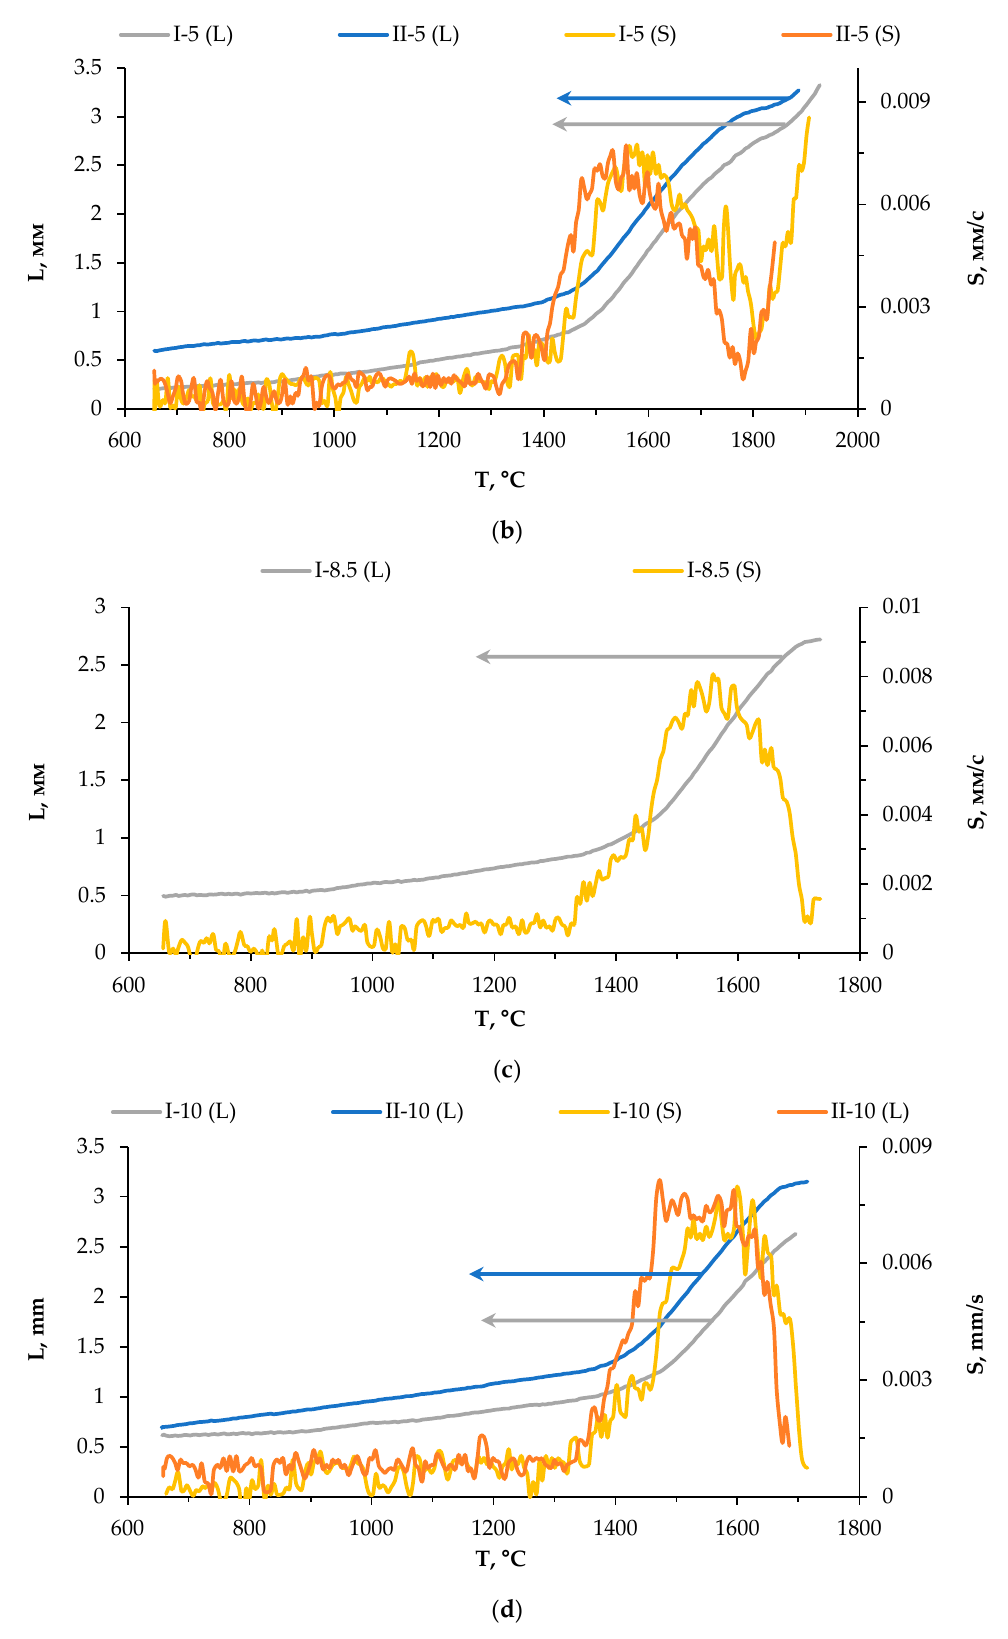
Figure 3. Shrinkage and shrinkage rate vs temperature during SPS of the powder mixtures with different amounts of the sintering additive: ( a ) 3% wt.; ( b ) 5% wt.; ( c ) 8.5% wt.; ( d ) 10% wt.